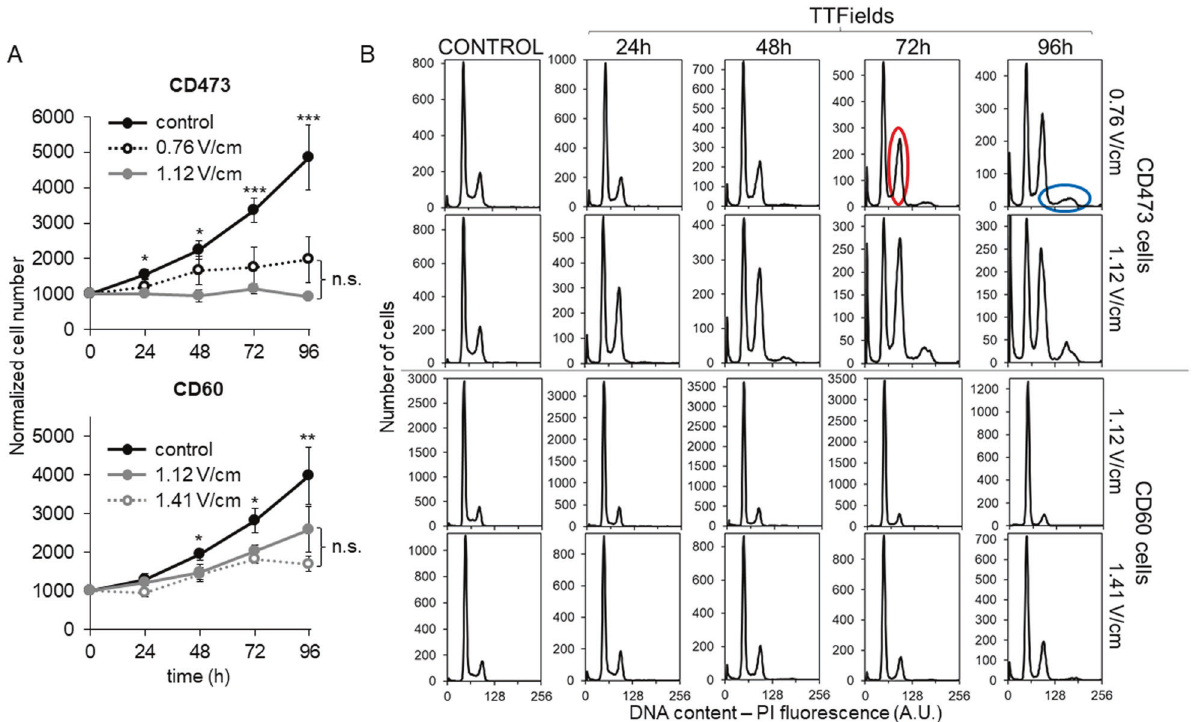
Fig. 2 Intensity-dependence of the antiproliferative effects of TTFields. A Growth curves of epithelioid CD473 and sarcomatoid CD60 cells during TTFields treatment at two different intensities or under control conditions. Each symbol represents the mean cell number of four replicates in at least two biological independent experiments with its standard deviation. Statistical signi fi cance was analyzed by one-way Anova test (* p < 0.05; ** p < 0.01; *** p < 0.001). The differences observed between the two treated samples were not statistically signi fi cant (n.s.). B Representative DNA histograms of epithelioid CD473 and sarcomatoid CD60 controls and treated samples are shown. Examples of polyploid or G 2 M blocked cells are outlined in blue and in red, respectively. Fluorescence signals are reported as arbitrary units